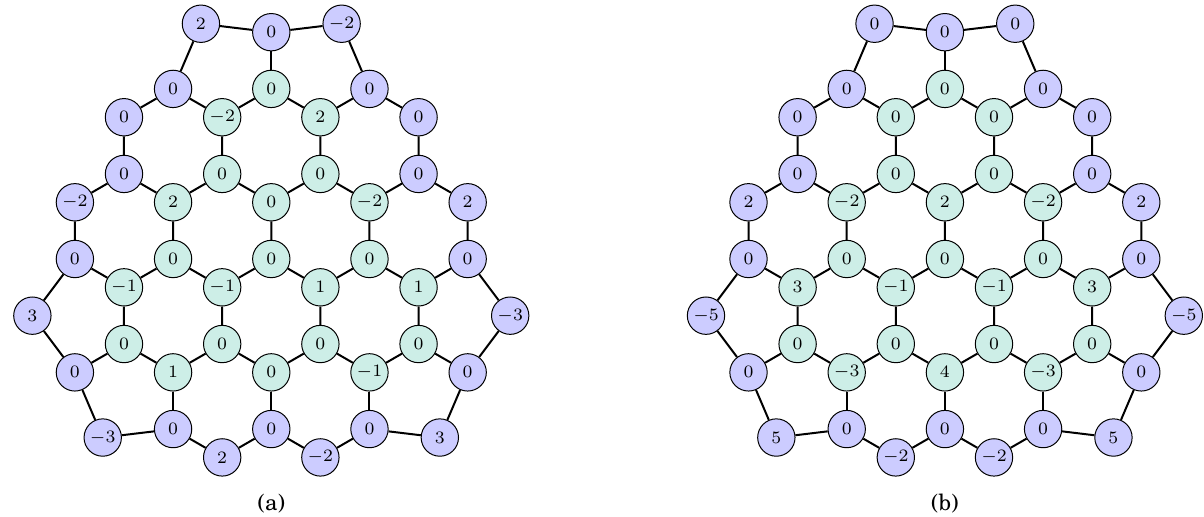
Figure 4: Demonstration of extendability of an antisymmetric and a symmetric kernel eigenvector for H (3 , 1 , 1 , 1) . Arbi- trary antisymmetric and symmetric extensions do not necessarily form a pure E